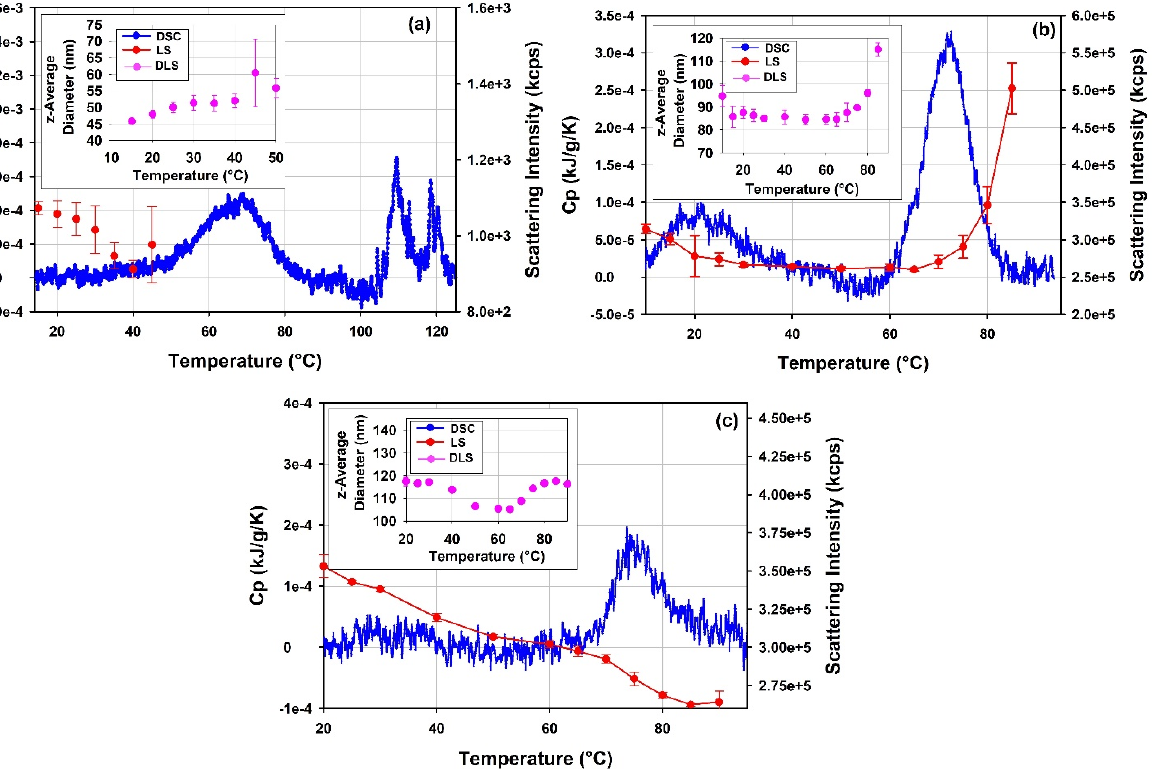
Figure 16. DSC thermograms overlaid on DLS thermal ramp data displayed as light scattering intensity vs. temperature for ( a ) the free mRNA, ( b ) mRNA-LNP1 and ( c ) mRNA-LNP2. The inserts present the dependence of the z-average diameter on temperature for the respective samples. To facilitate the comparison, DSC data are shown normalized per mass concentration of the sample, i.e., per gram of mRNA for the free mRNA sample and per gram of total lipids for mRNA-LNP1 and mRNA-LNP2, respectively.